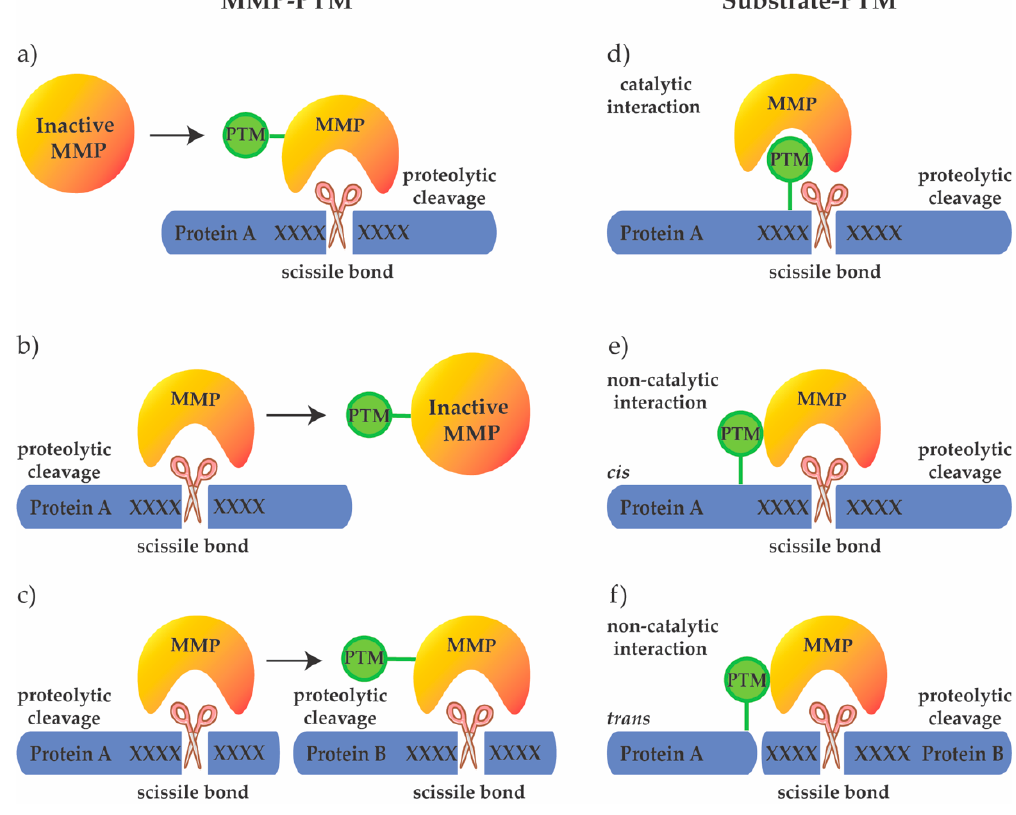
Figure 2. Possibilities of PTM crosstalk with MMPs. PTMs can regulate the activity of MMPs on the protease level by ( a ) activating the protease to allow cleavage of the target protein, ( b ) inactivating the protease, or ( c ) modulating its substrate specificity. Additionally, PTMs may regulate substrate cleavage by MMPs, through ( d ) directly modifying the cleavage motif (catalytic interaction), or substrate domains outside the cleavage site (non-catalytic interaction), guiding MMPs to cleave the same ( cis ) ( e ) or another ( trans ) protein ( f ).